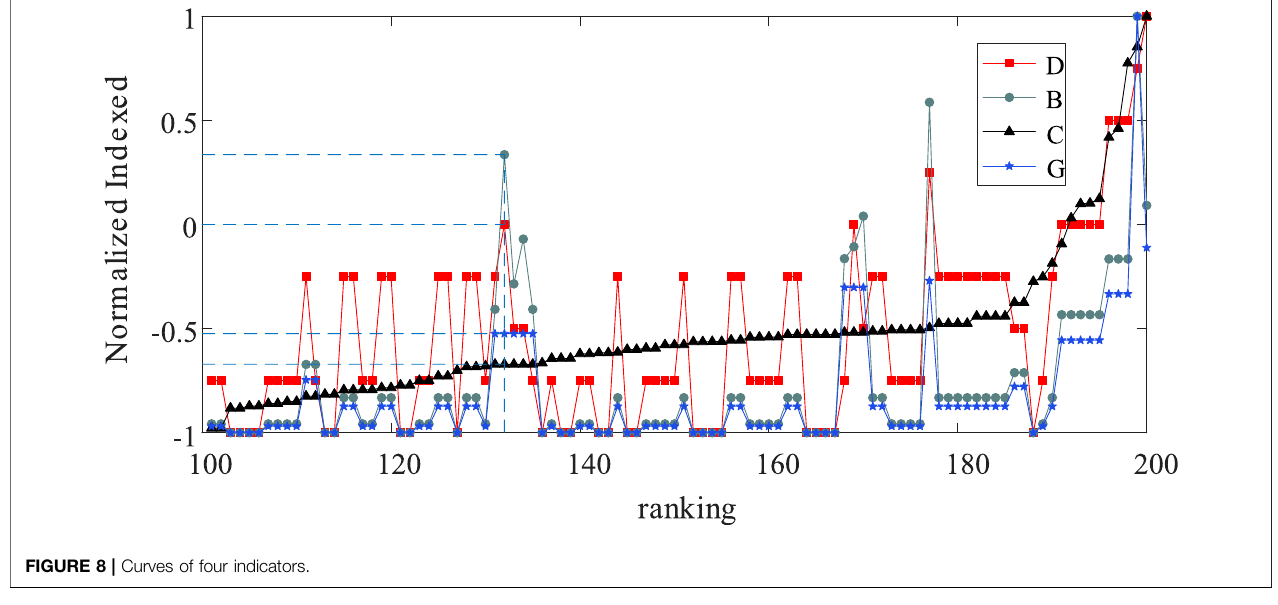
FIGURE 8 | Curves of four indicators.